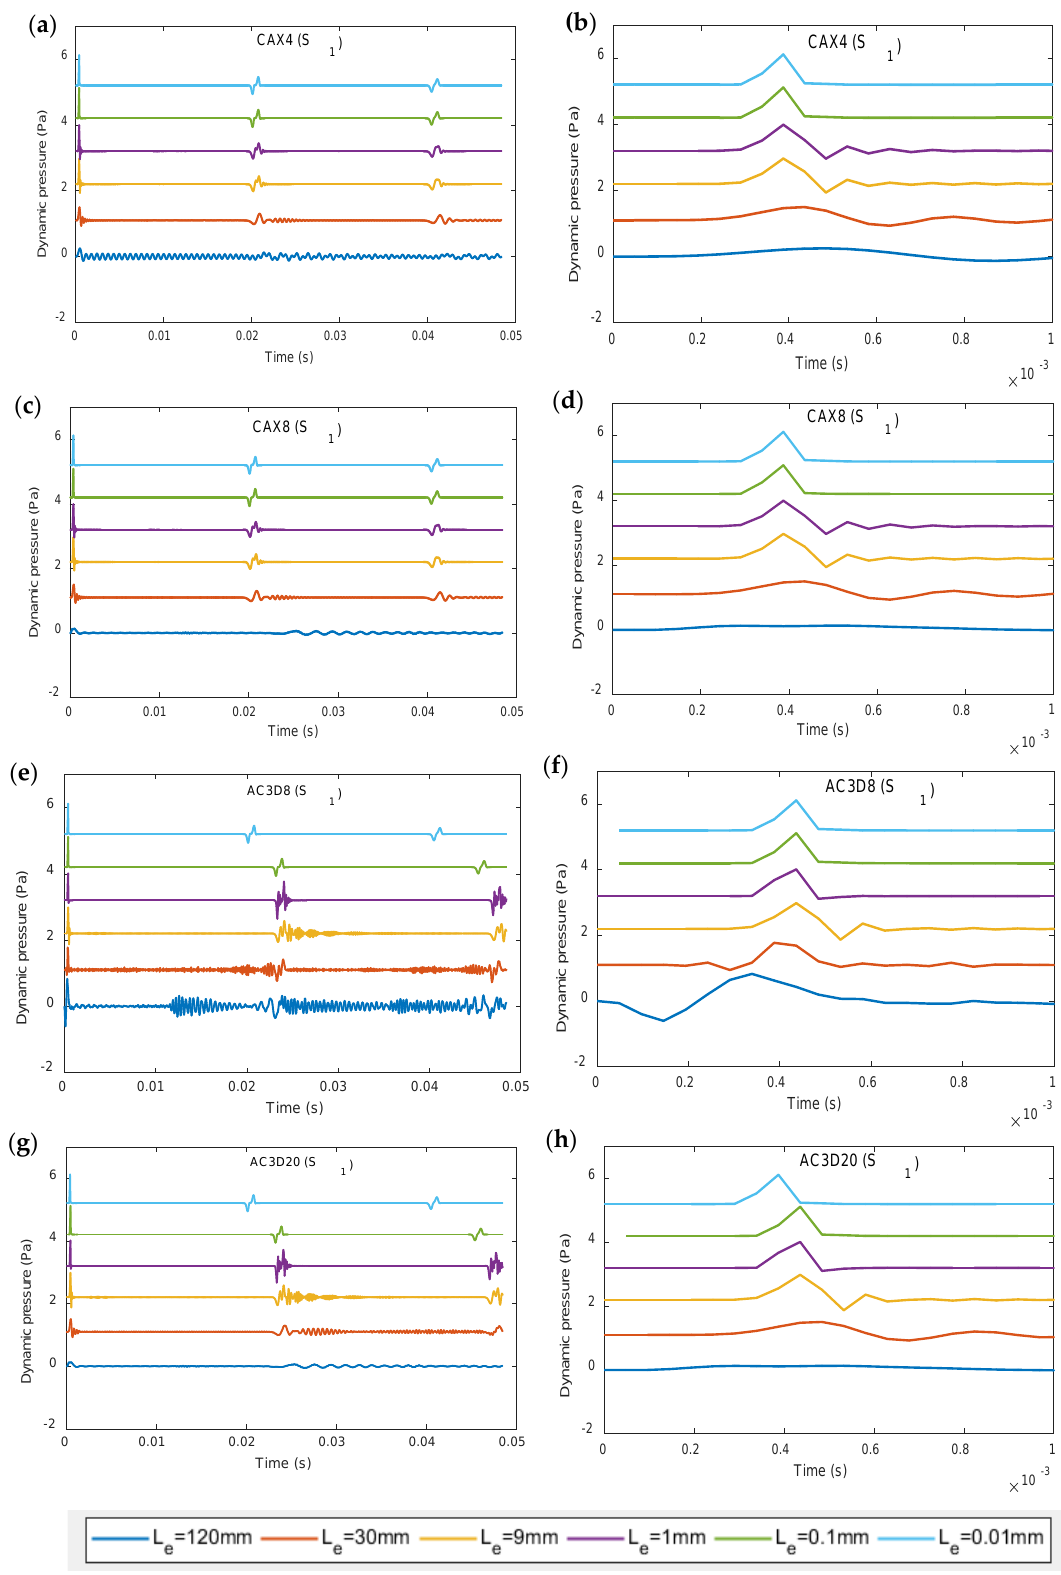
using ACAX4, ACAX8, AC3D8 and 𝑟𝑟 1 𝑟𝑟 1